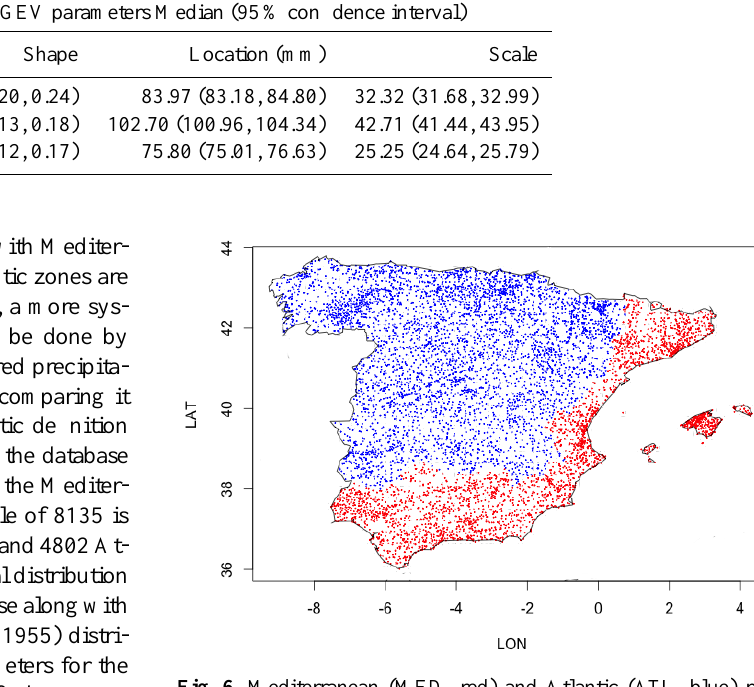
Fig. 6. Mediterranean (MED, red) and Atlantic (ATL, blue) rain gauge Figure 6.- Mediterranean (MED, red) and atlantic (ATL, blue) rain gauge stations